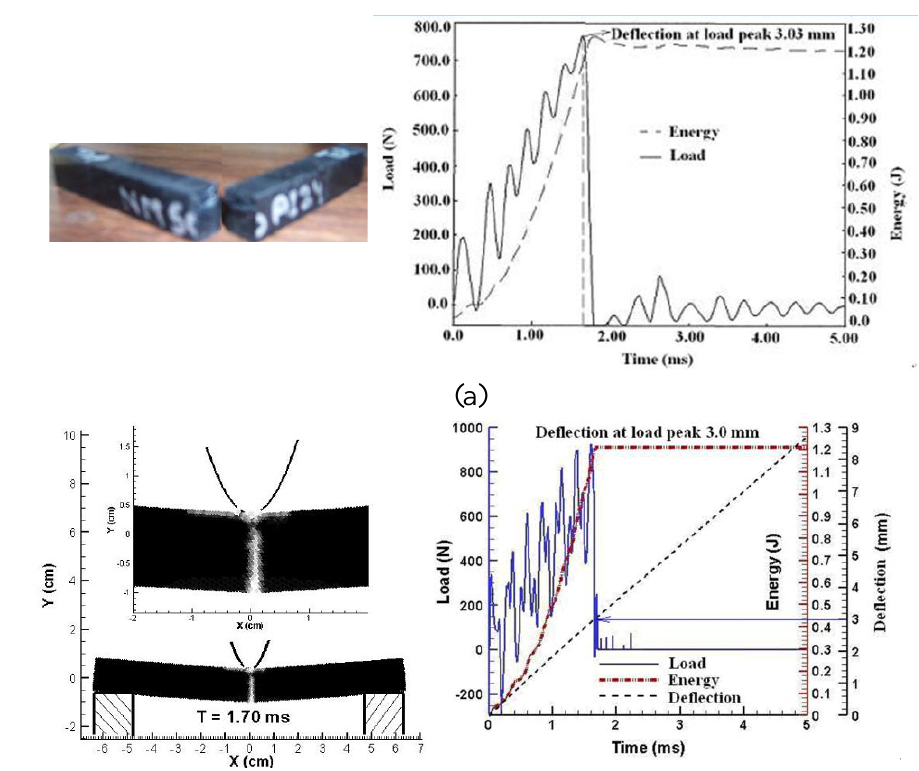
(a) experimental results; (b) HLPM results. Maximum drop velocity of